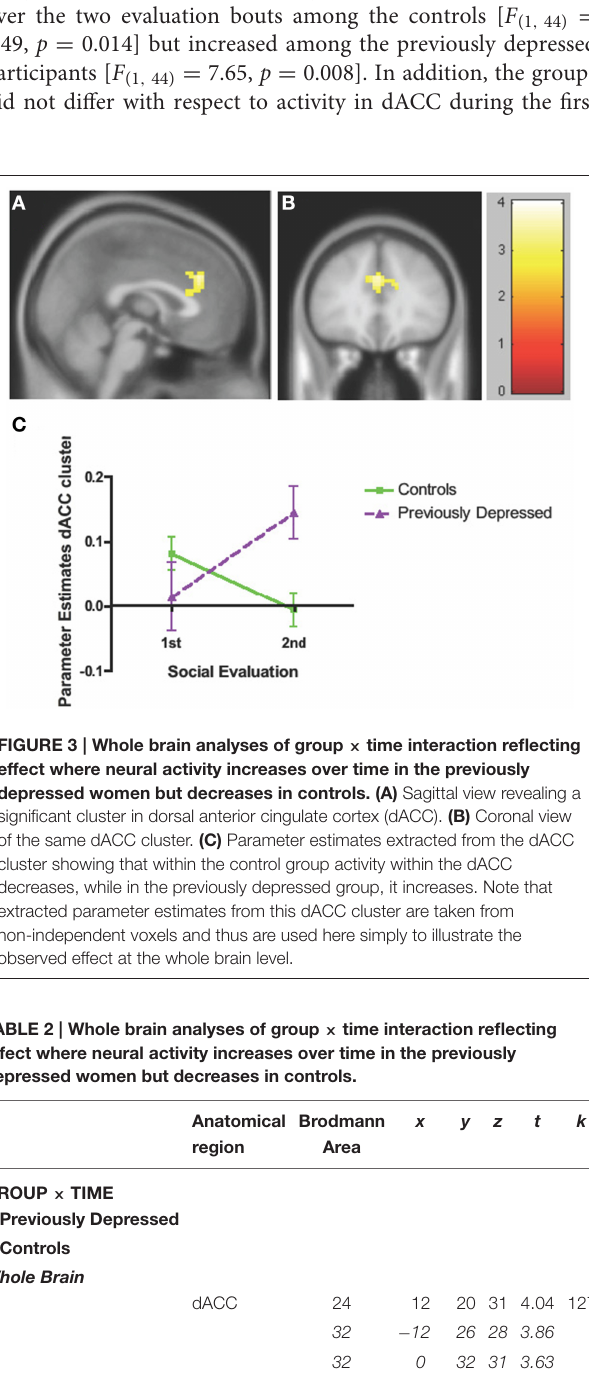
FIGURE 2 | Change in Psychological States from Pre- to Post-scan during the Social Evaluative Session. (A) Feelings of social evaluation. (B) Depressed mood. Main effect of Time shown. ** p < 0.001; * p < 0.05.